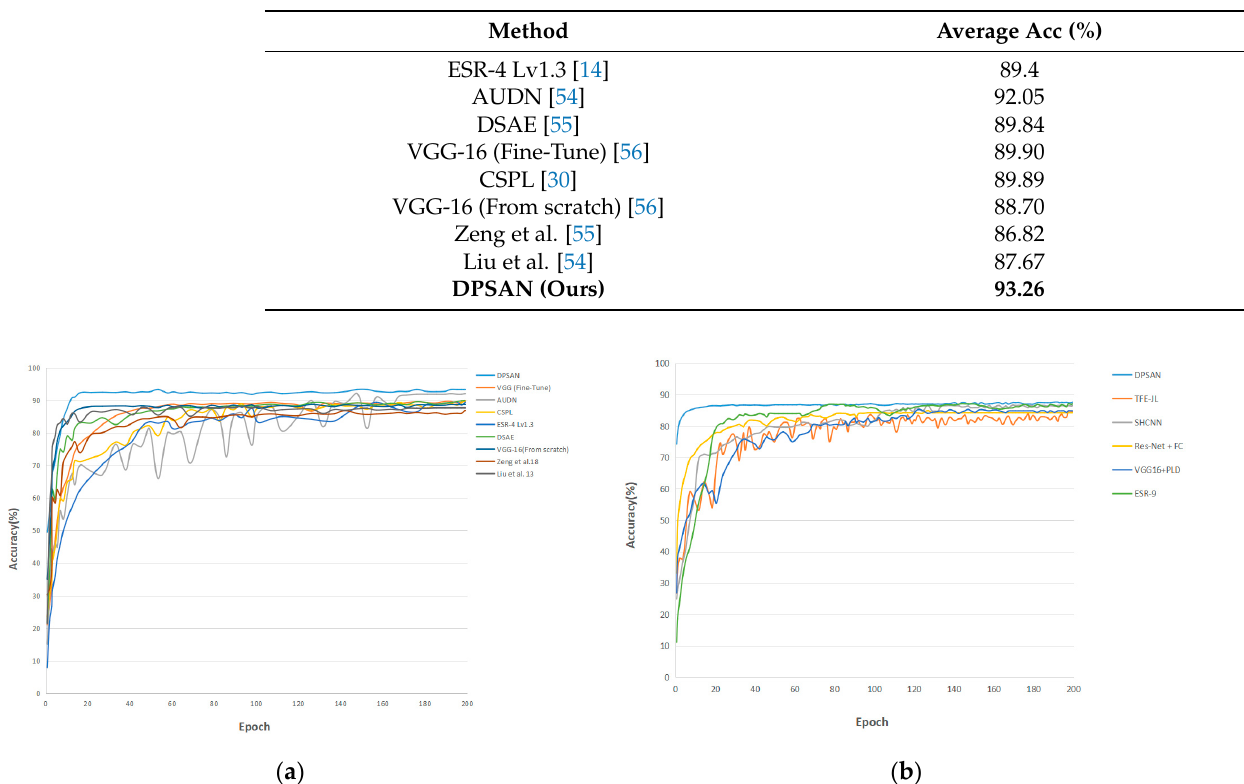
Table 2. Comparison of DPSAN with other models on the CK+ dataset.